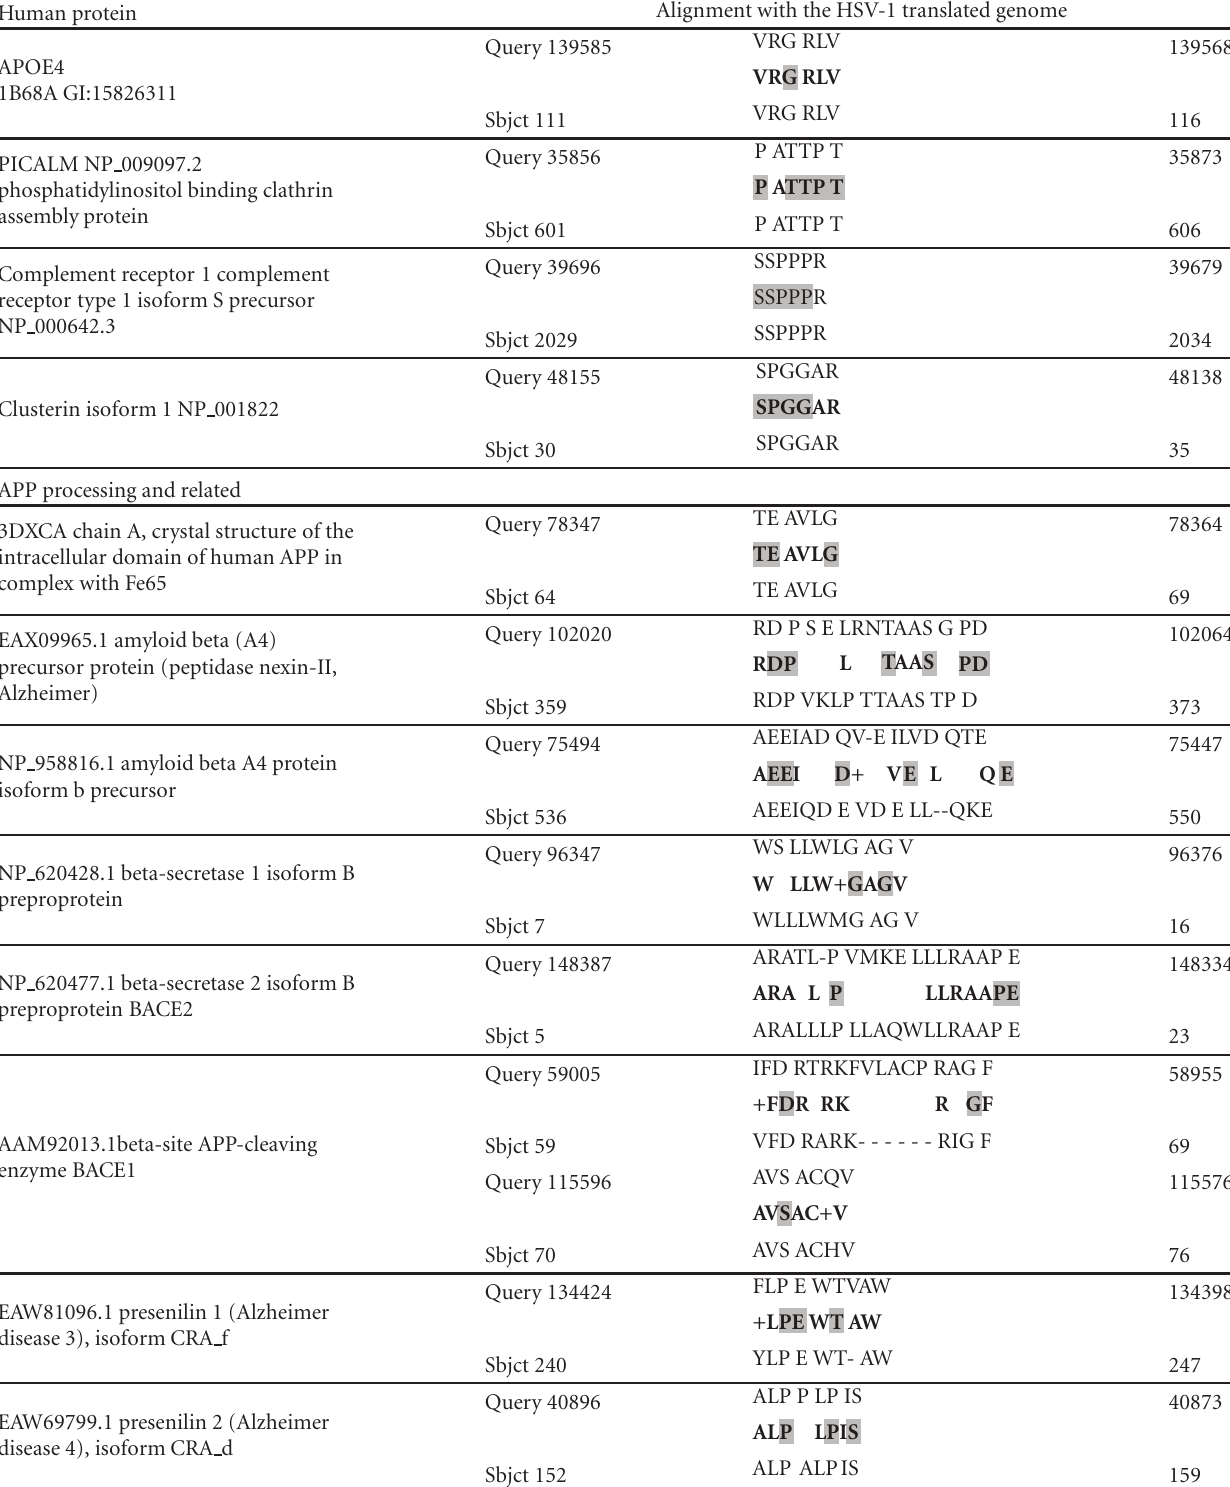
Table 3: Major susceptibility gene products and members of other key signalling networks in Alzheimer’s disease (Sbjct) aligning with the translated HSV-1 genome (Query). The 6 amino acids with the highest B cell antigenicity index are highlighted in grey (see Table 1). Spaces denote a nonidentical amino acid; dashes represent gaps and + = conserved amino acid (similar physicochemical properties). Alignment with the HSV-1 translated